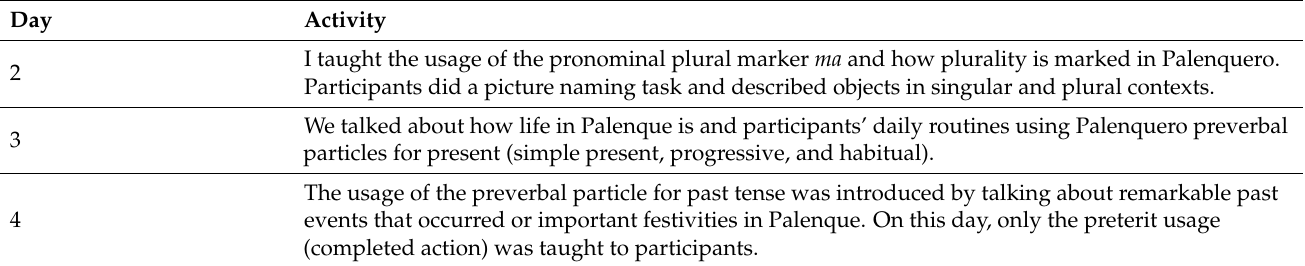
Table 4. Researcher/Teacher’s Journal